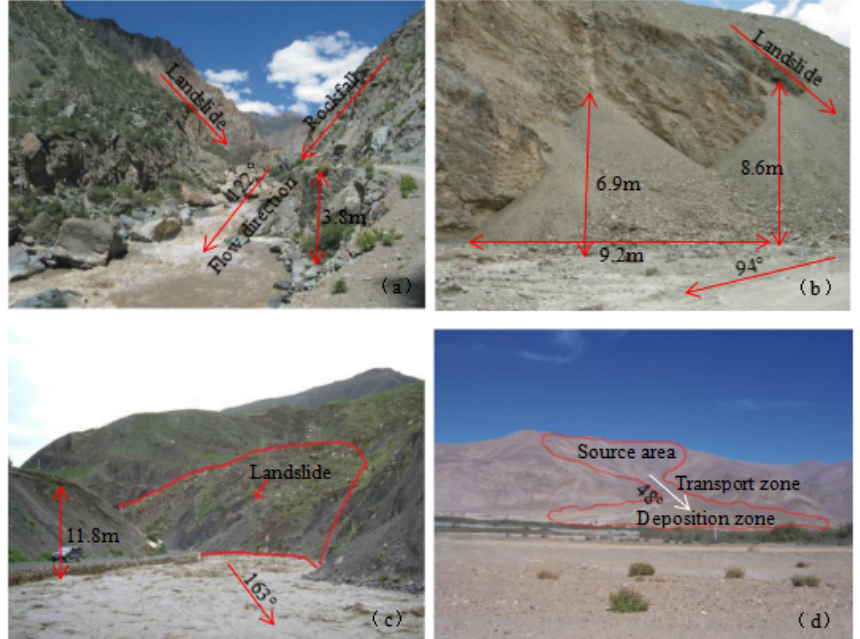
Figure 2. Photos of landslide or debris flow: (a) Lunba landslide in a tributary, (b) Zhenqiong landslide in Jiayu village, (c) debris flow in Misha township and (d) debris flow in Lelong village.